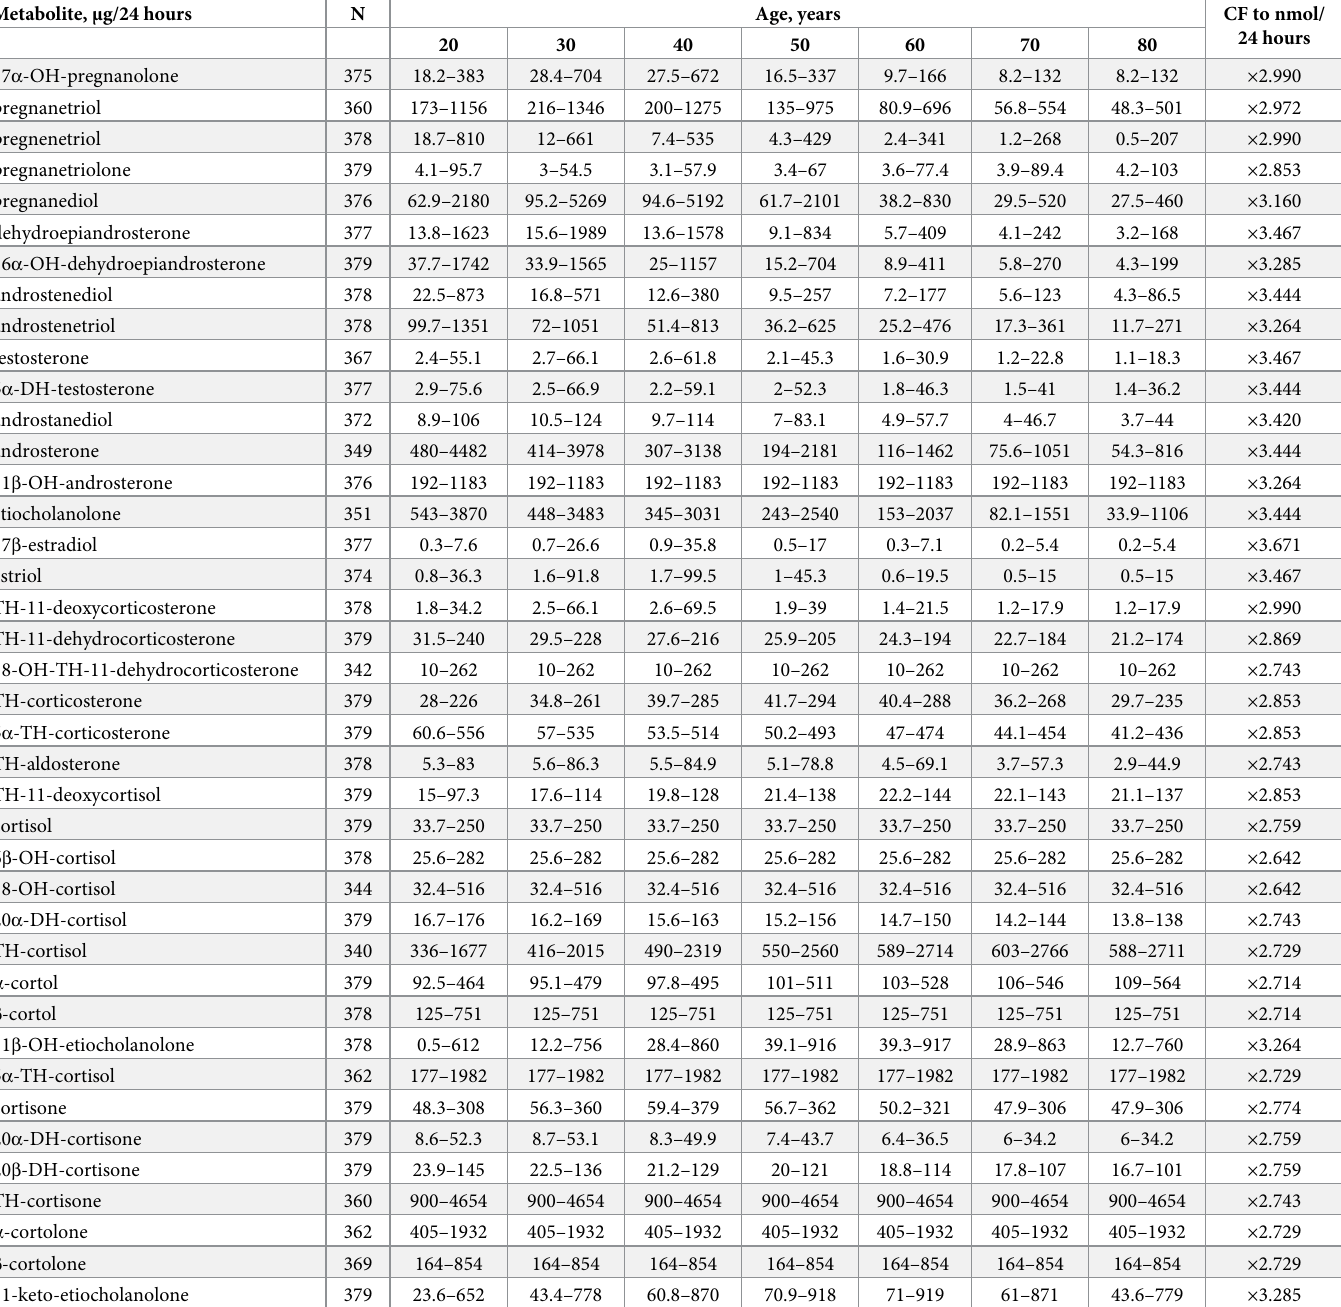
Table 3. Reference intervals for 40 steroid metabolites in 24-hour urine in